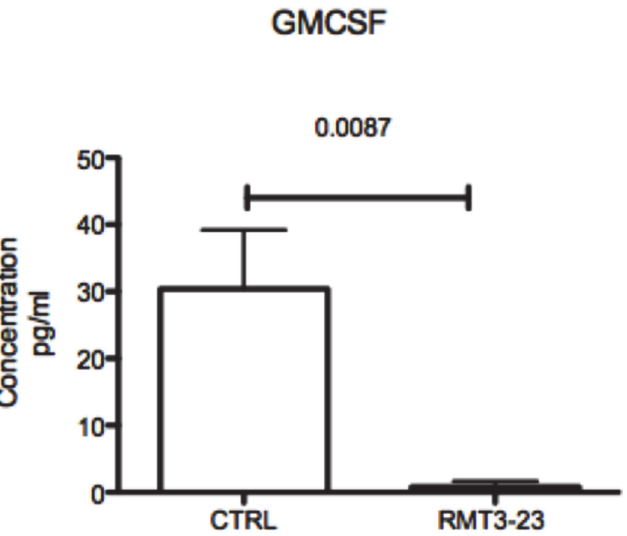
Fig 6. GMCSF concentration in the placenta of CBA/CaJ mice at GD 12.5 following TIM-3 blockade. A significant decrease in the GMCSF concentration was observed in the placenta of RMT3-23 treated mice in comparison to control. Data are presented as mean ± SEM and are representative of at least 3 experiments. Statistical analysis was done using unpaired t test.